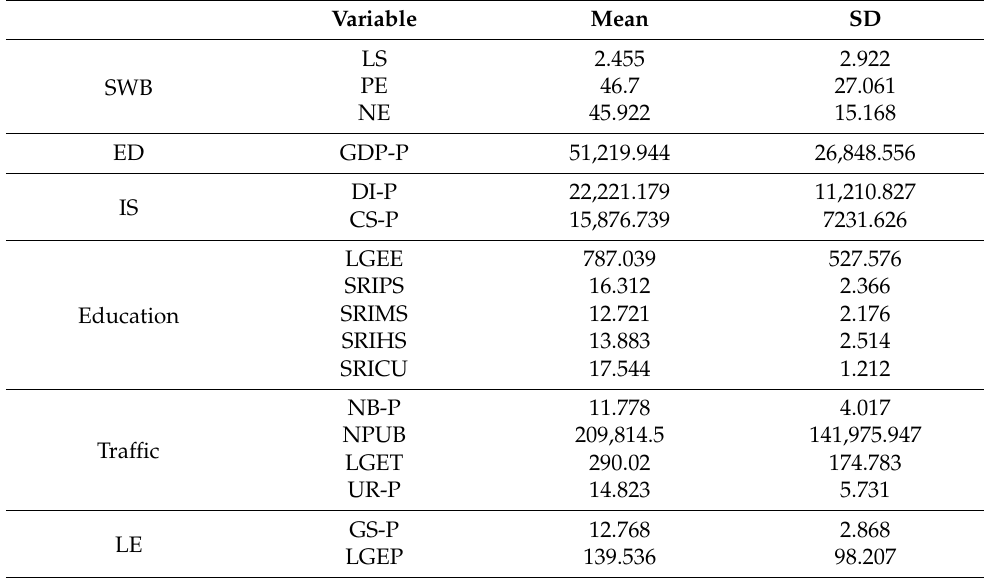
Table 2. Descriptive statistics for key